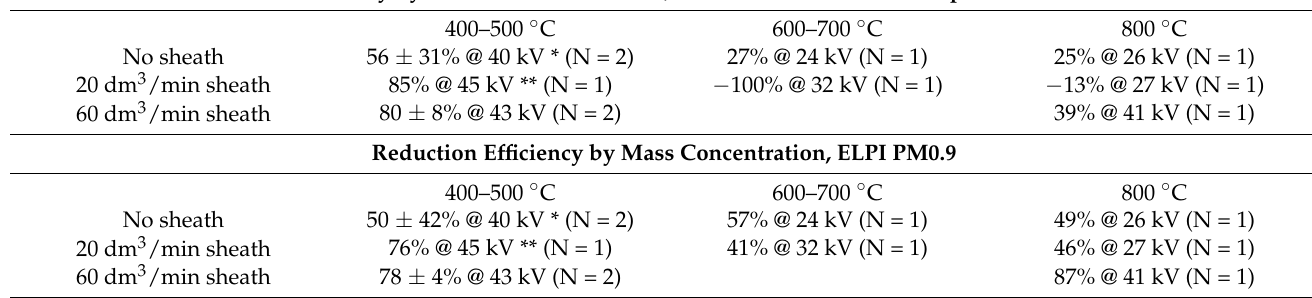
Table 2. Shielded corona charger (SCC)-induced reduction efficiencies of particulate matter (PM) and particle number emissions measured upstream of the heat exchanger at different operating conditions. N is the number of repeated individual experiments. The result of each individual experiment is averaged over a measurement time varying between 10 and 35 min under stable conditions.